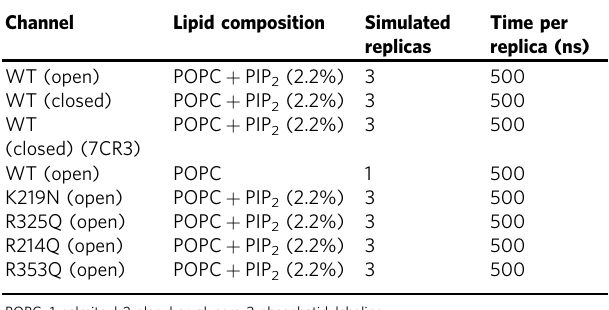
Table 1 Details of the systems and the simulations